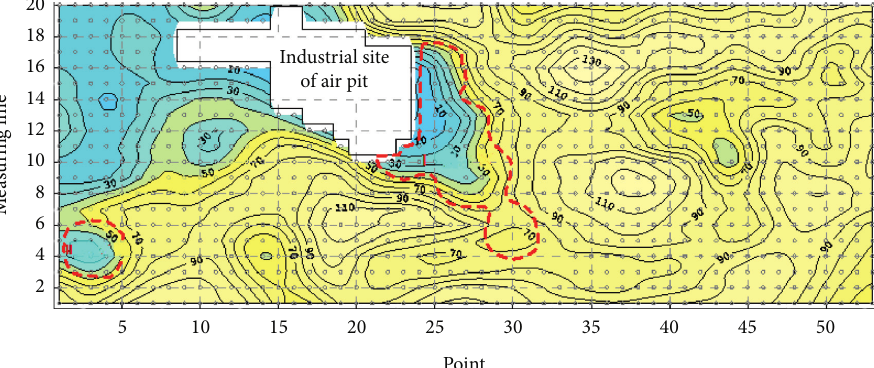
Figure 16: Plan of apparent resistivity of 8 # coal seam.